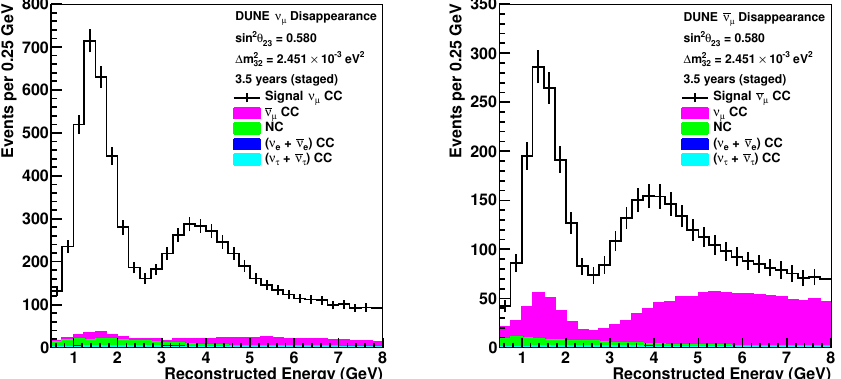
Figure 9. ν µ and ¯ ν µ disappearance spectra: reconstructed energy distribution of selected ν µ CC- like events assuming assuming 336kt-MW-years exposure, with equal running in the neutrino and antineutrino-beam mode. Statistical uncertainties are shown on the datapoints. The plots assume normal mass ordering